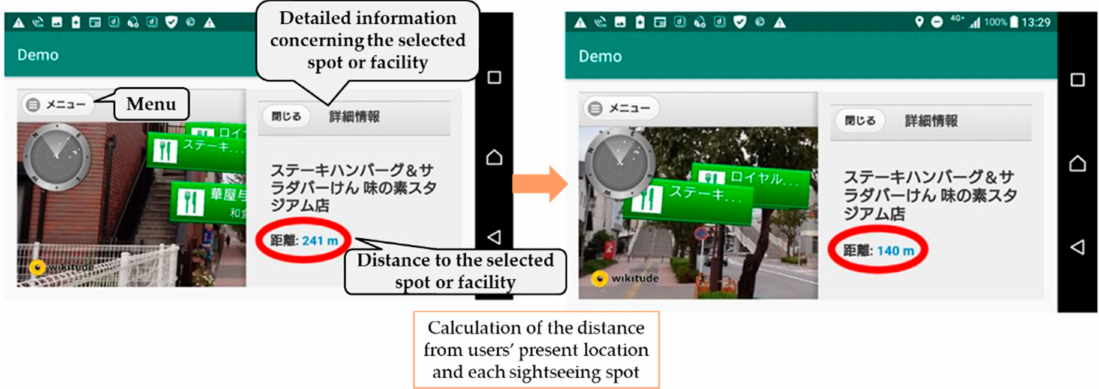
Figure 9. Real-time updates of distance information.